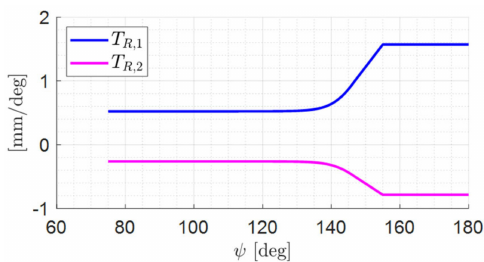
Figure 5. Transmission ratios of the two